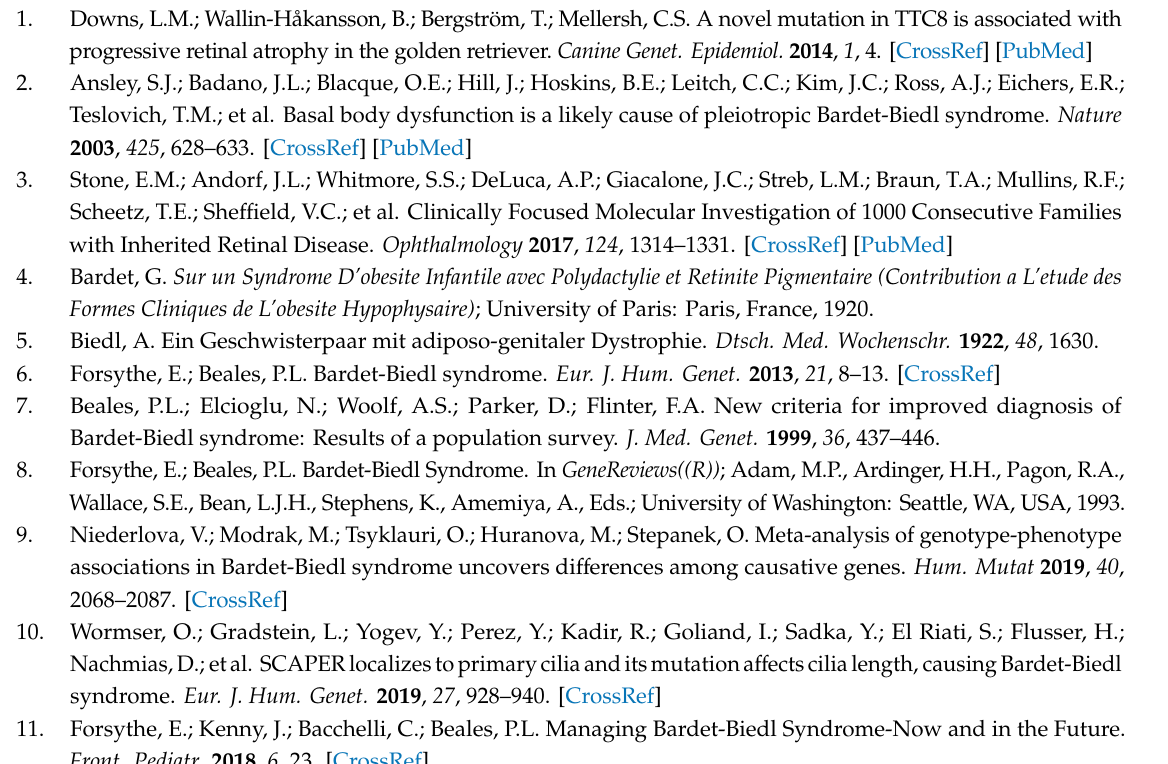
Figure S1: Retinal changes associated with TTC8 delA , Table S1: List of dogs included for OCT and / or collection of tissue samples, Table S2: Primary and secondary characteristics, Table S3: Macroscopic and microscopic examination, Table S4: Marker gene expression, Table S5: Primers, Table S6: Human TTC8